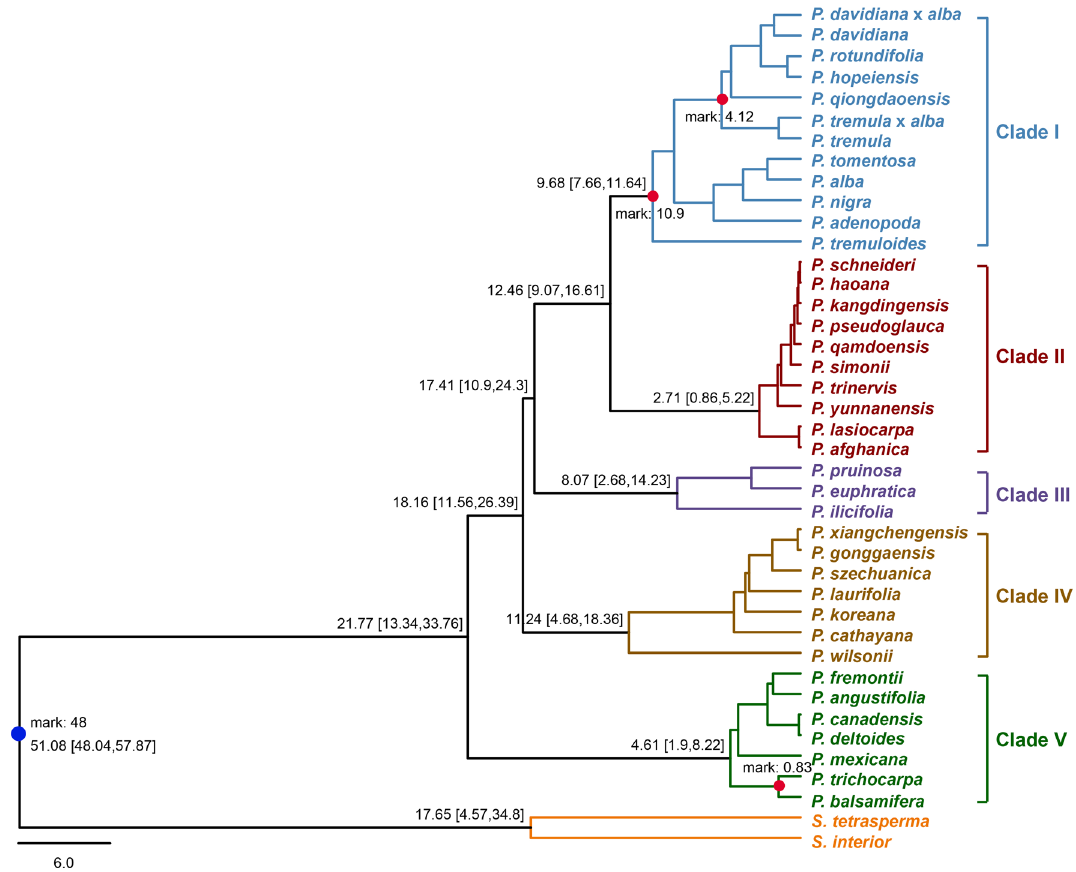
Figure 8. Ages of selected lineages of Populus inferred from 76 chloroplast genes. The blue dot indicates the earliest known fossils of ancestral Populus species 44 , and red dots represent calibrations used from the TimeTree website (http:// www. timet ree. org).